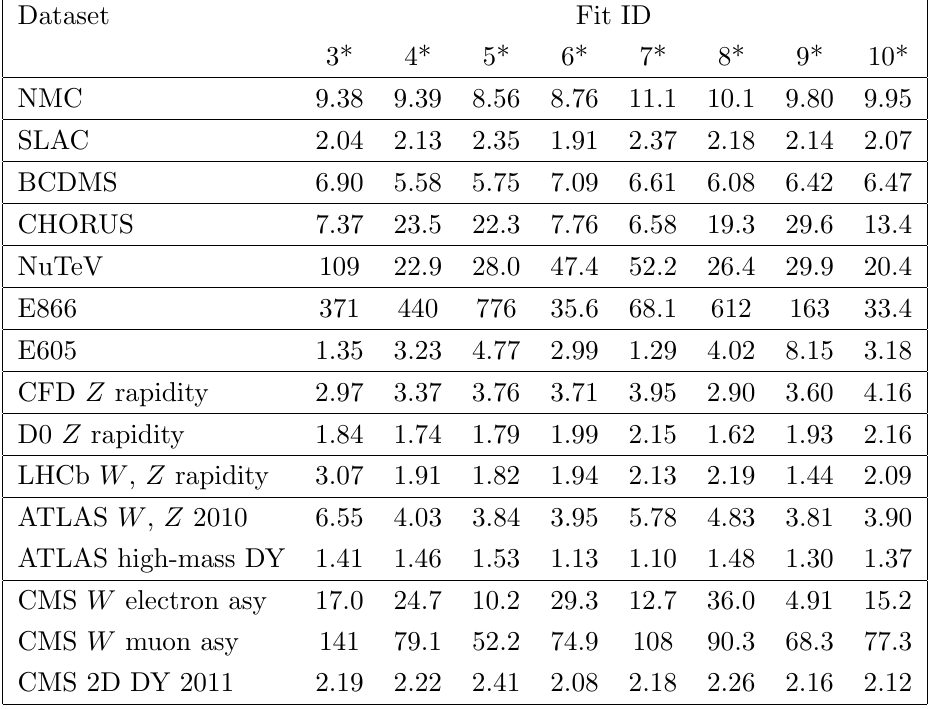
Table 10 . The (cid:31) 2 per data point of the experiments not included in the HERA-only (cid:12)ts performed in appendix A (see also table 8), computed with the outcome of the corresponding HERA-only (cid:12)ts.